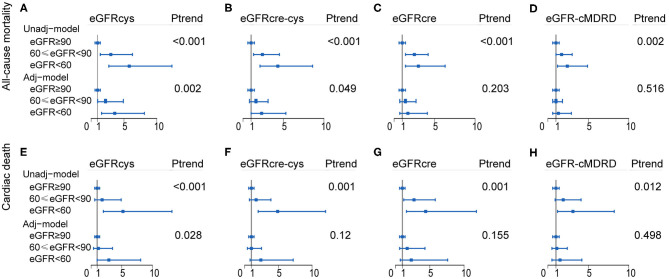
Forest plot showing the risk assessment of event across renal levels. HR and 95% CI of the association between both all-cause mortality (A–D) and cardiac death (E–H) and the eGFR calculated by of four equations. Group 1 (eGFR ≥ 90 ml/min/1.73 m2) as reference group, Group 2 (60 ≤ eGFR <90 ml/min/1.73 m2), and Group 3 (eGFR <60 ml/min/1.73 m2) were compared with it, separately. Adj-model was adjusted for baseline variables significantly and factors closely related to the outcome of patients with cardiovascular disease, such as age, sex, smoking, body mass index (BMI), diabetes mellitus (DM), hypertension (HT), and low-density lipoprotein cholesterol (LDL-c), left ventricular ejection fraction (LVEF), C-reactive protein (CRP), and procedural success. Unadj-model, Unadjusted model; Adj-model, Adjusted model; Ptrend, P for trend.